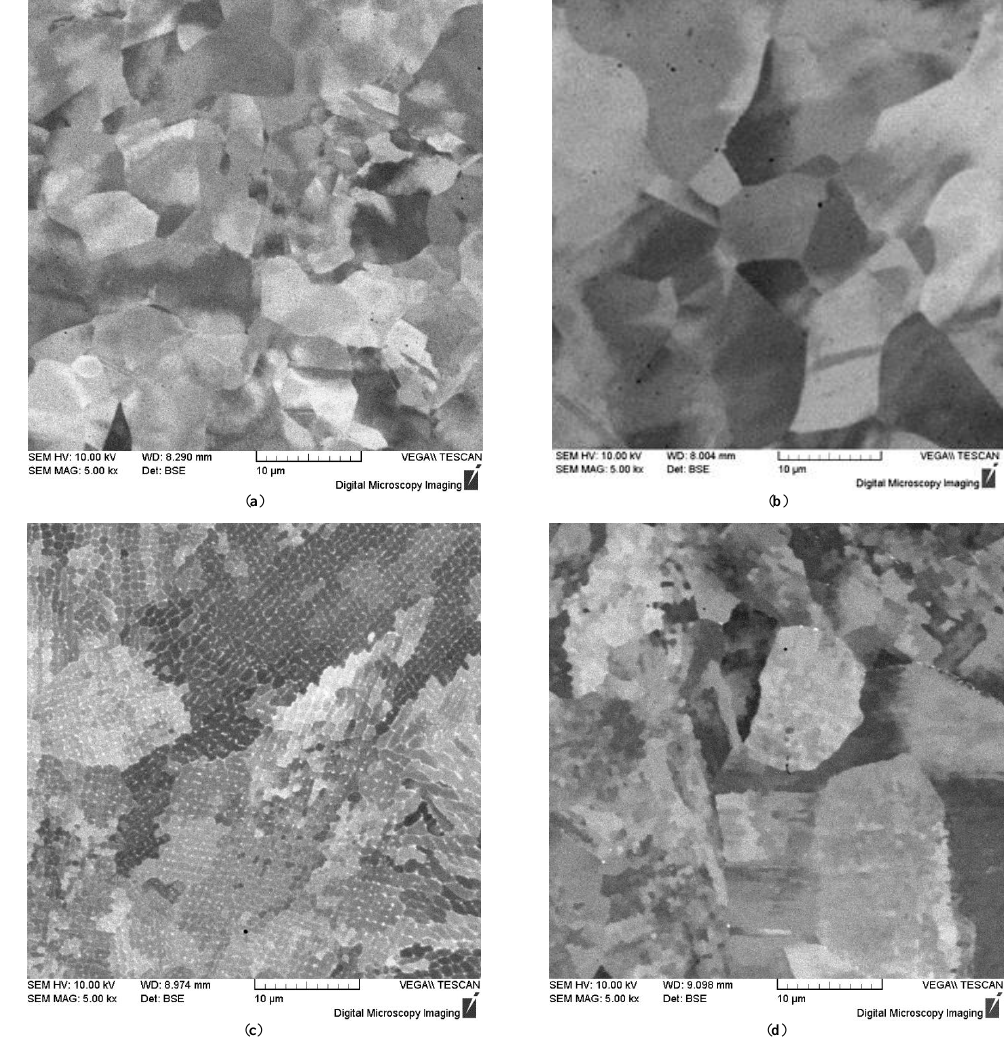
Figure 9. SEM images of the microstructure of SLM specimens of 316L steel ( a , b ) and Inconel 718 alloy ( c , d ) obtained before ( a , c ) and after ( b , d ) high-temperature hydrogen permeability tests (XY plane). Figures 9c,d show the characteristic microstructure obtained on SLM Inconel 718. On the specimens before the high temperature hydrogen permeability tests (Figure 9c), a grain structure with an average grain size of about 10 μm and a cellular structure with an average cell size of about 2 μm were observed. The presence of cells in the Inconel 718 alloy is usually associated with the Laves phase [40,41]. The grain structure of Inconel 718 alloy did not change significantly after high-temperature hydrogen permeability tests, a slight increase in the average grain size up to 15 μm being observed (Figure 9d). It should be noted that the cells of the Laves phase disappeared completely after the high-temperature hydrogen permeability tests. Changing grain structure in SLM materials after high-temperature hydrogen permea- bility testing indicates the start of a recrystallization process. Recrystallization normally oc- curs after heating the deformed material due to a decrease in the elastic strain energy [42,43]. In SLM-processed specimens, rapid solidification may cause residual stresses [44–48], which create a certain reserve of elastic energy. When a specimen is heated to high temperatures (prior to hydrogen permeability testing, the membrane specimen was subjected to high-temperature treatment, which was a guarantee of reliable degassing of the membrane and chamber walls from residual hydrogen), recrystallization processes of the material may be activated. Changes in the membrane specimen structure as a result of high-temperature hydrogen permeability testing are accompanied by a decrease in the microhardness of 316L steel from 2600 to 2100 MPa, which also confirms the beginning of recrystallization. It should be noted, however, that the microhardness of steel after high-temperature hydrogen perme- ability testing remains very high compared with the microhardness of the base metal and weld joints of 316L steel specimens [49]. The recrystallization process during high temperature tests of 316L and Inconel 718 al- loy specimens in a hydrogen environment was confirmed by the X-ray diffraction analysis results. Figure 10а shows X-ray diffraction patterns for 316L steel in various states (powder, SLM specimen, and SLM specimen after high-temperature tests in a hydrogen environment), and Figure 10b demonstrates the results of X-ray diffraction analysis of Inconel 718 alloy specimens. ( -Fe austenite X-ray peak (220) at large diffraction an-